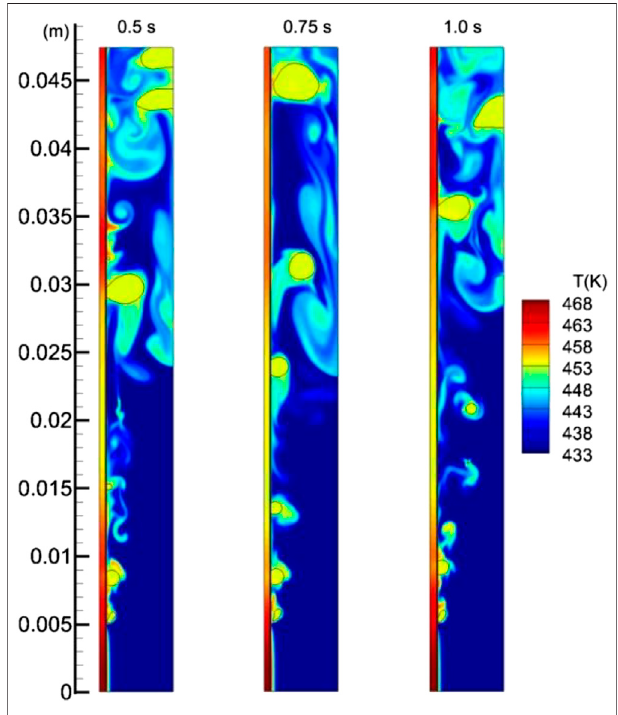
FIGURE 4 | Temperature fi eld at wall heat fl ux of 100 kW/m 2 .